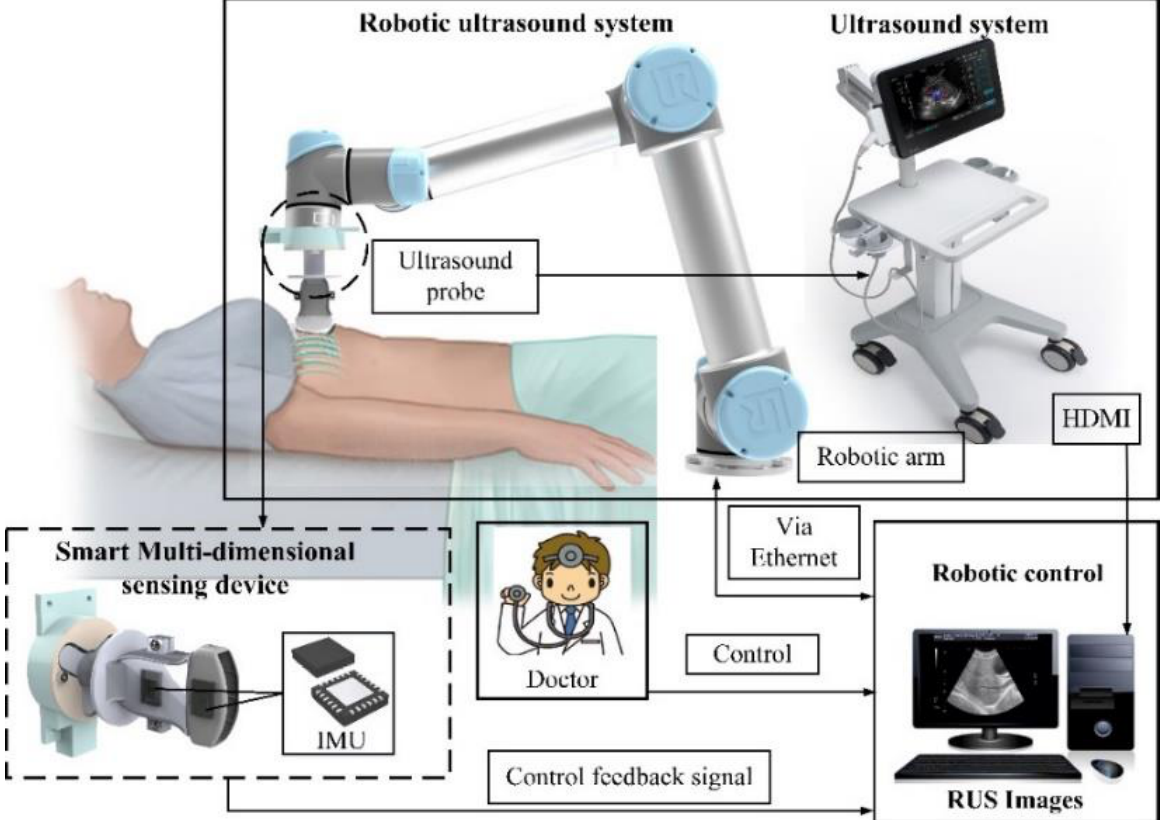
Figure 1. System